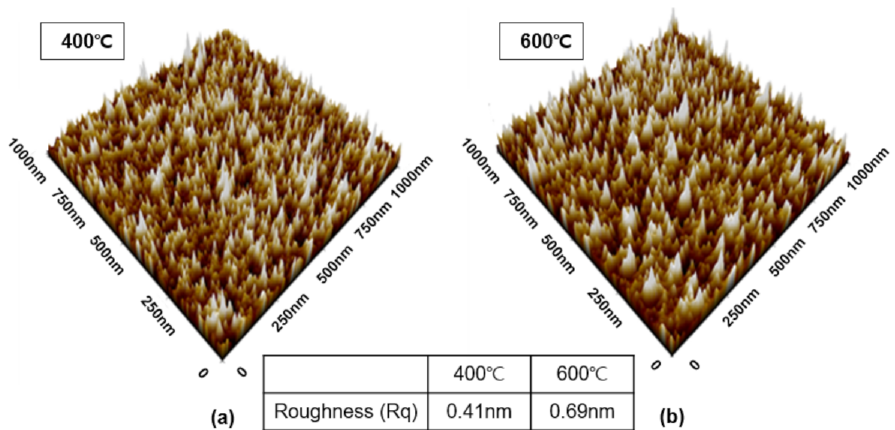
Figure 6. AFM analysis to determine surface roughness of TiN thin films based on deposition temperature: ( a ) 400 ◦ C, ( b ) 600 ◦ C.